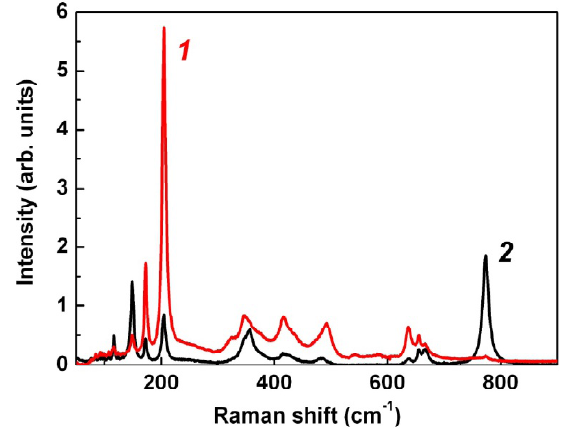
Fig. 4. Raman scattering spectra of (010)  –Ga sample obtained for z ( xx ) z (spectrum 1 ) and z ( yx ) z (spectrum 2 ) scattering